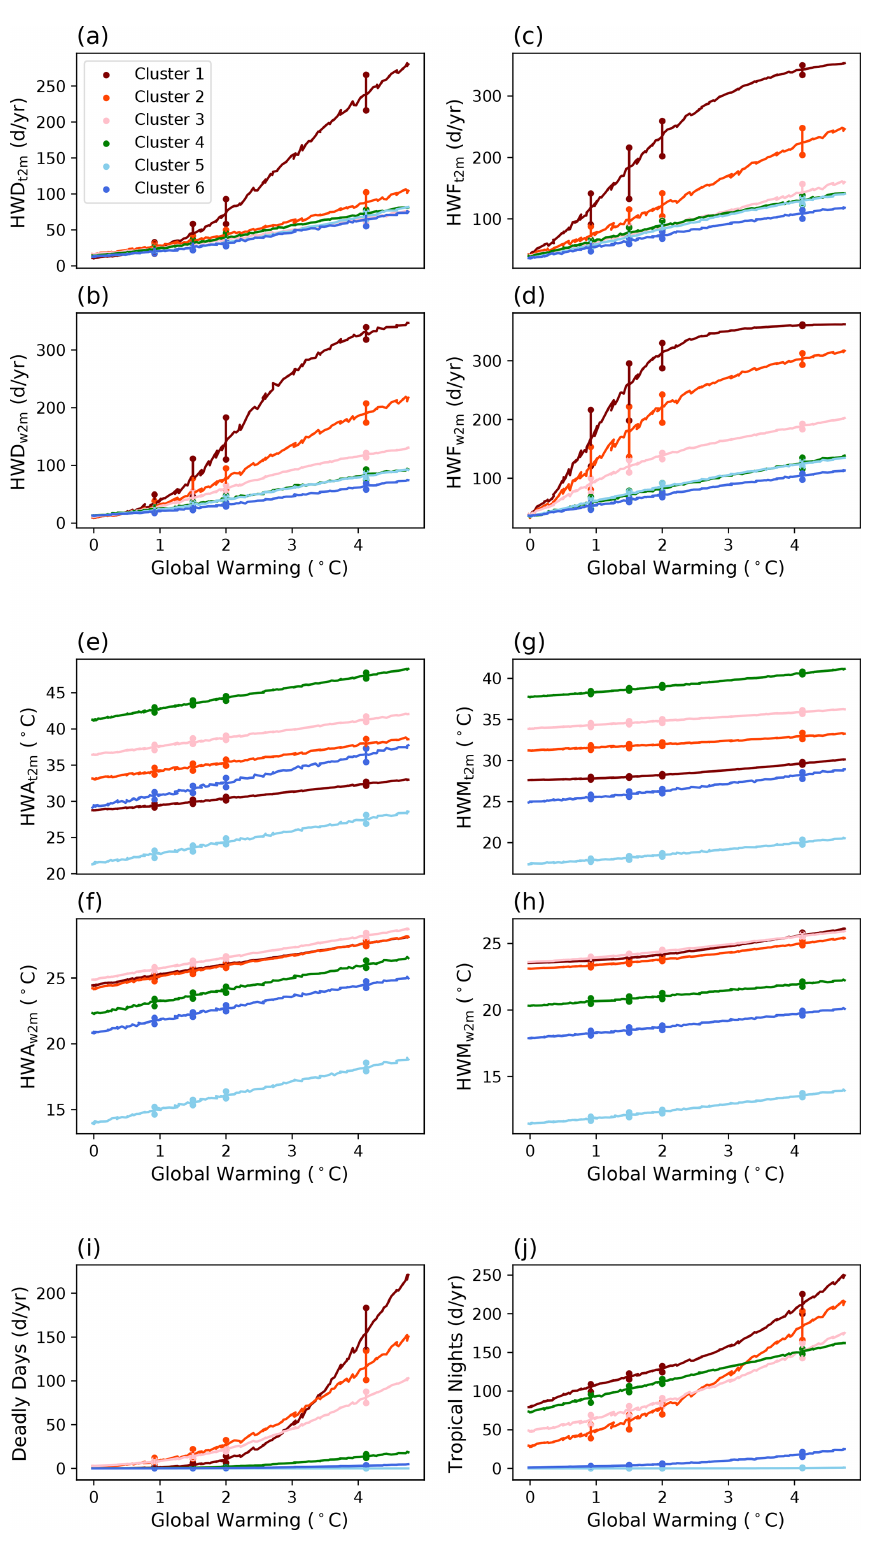
Figure 6. Evolution of each index averaged over each cluster. Colors are consistent with Fig. 5 and Table 2. The values of each metric are calculated by averaging the grid points that belong to each cluster. This was done for each ensemble member, and then the ensemble average is plotted. Vertical lines with dots show the maximum and minimum of 28 ensemble members at each threshold of warming to represent the spread between the ensemble